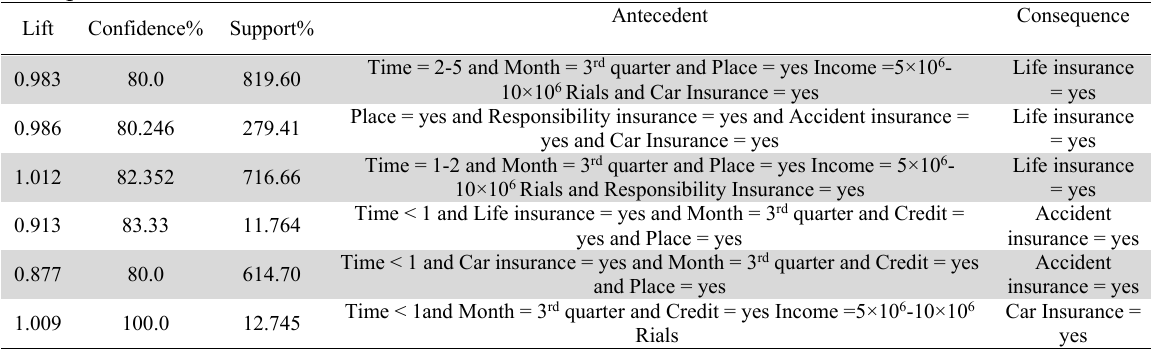
Examples of association rules in cluster 3